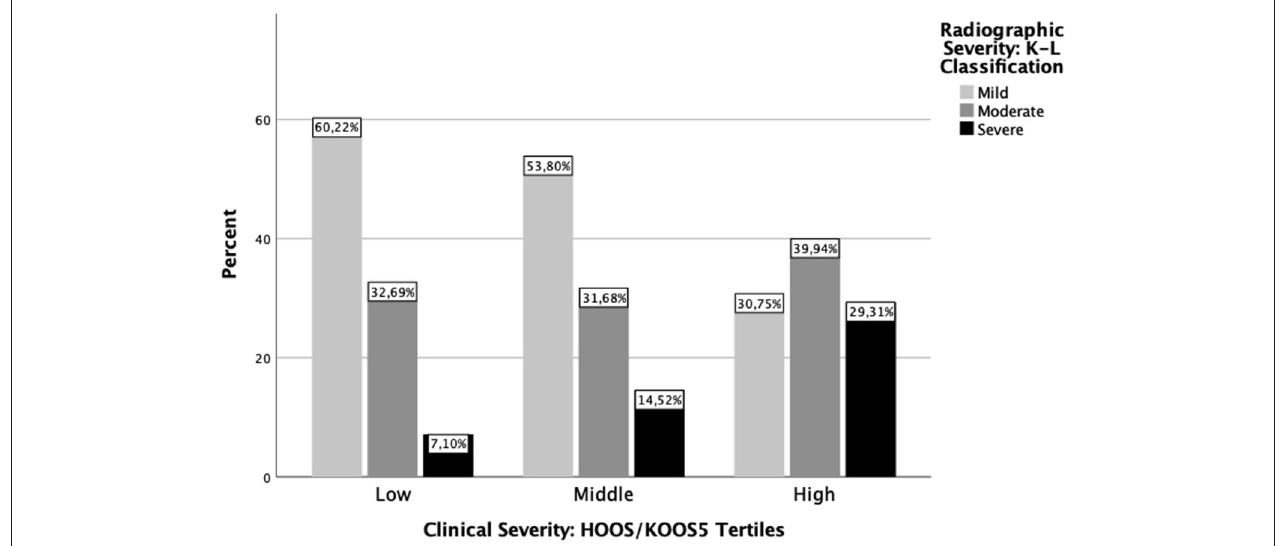
FIGURE 2 | Distribution of radiographic severity classification according to clinical severity tertile. The y-axis indicates the proportion of K-L classification grades within each HOOS/KOOS tertile, and the x-axis indicates HOOS/KOOS tertile. Bars represent K-L classification grade: mild ≥ 2, moderate = 3, or severe = 4.